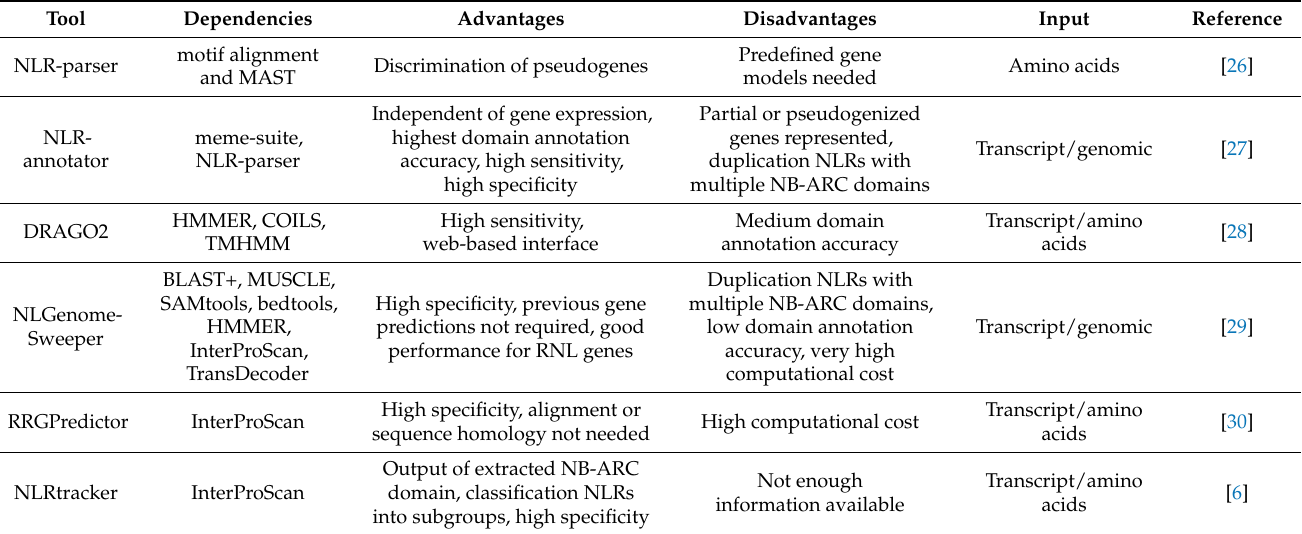
Table 1. Principal features of NLR-annotation